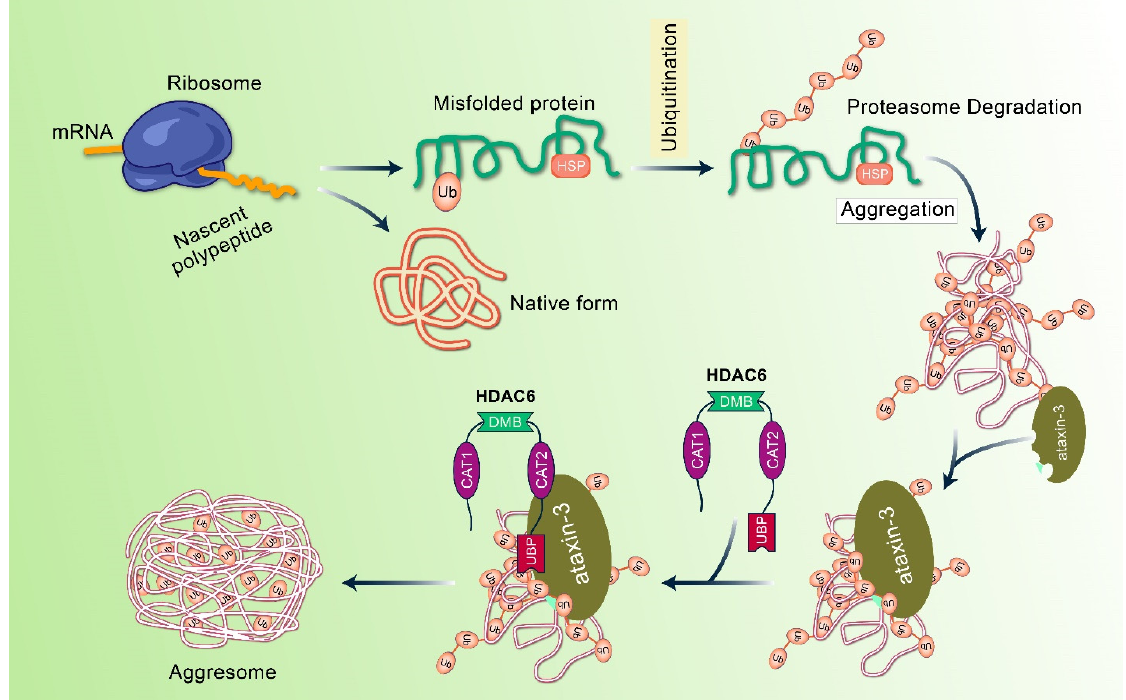
Figure 3. Molecular mechanism of aggresome development and formation. Under normal conditions, misfolded and polyubiquitinated proteins are fragmented via the ubiquitin proteasomal system. When ubiquitin proteasomal system is altered or overhauled, misfolded polyubiquitin proteins accumulate and form to aggregate. In this case, ataxin-3-dexiquitinase interrelates and aggregates with polyubiquitinated proteins to form ubiquitin chain structure. In addition, HDAC6 binds these non-anchored C-terminal tails of ubiquitin to form aggregates and recruits them into the dynein motor complex.